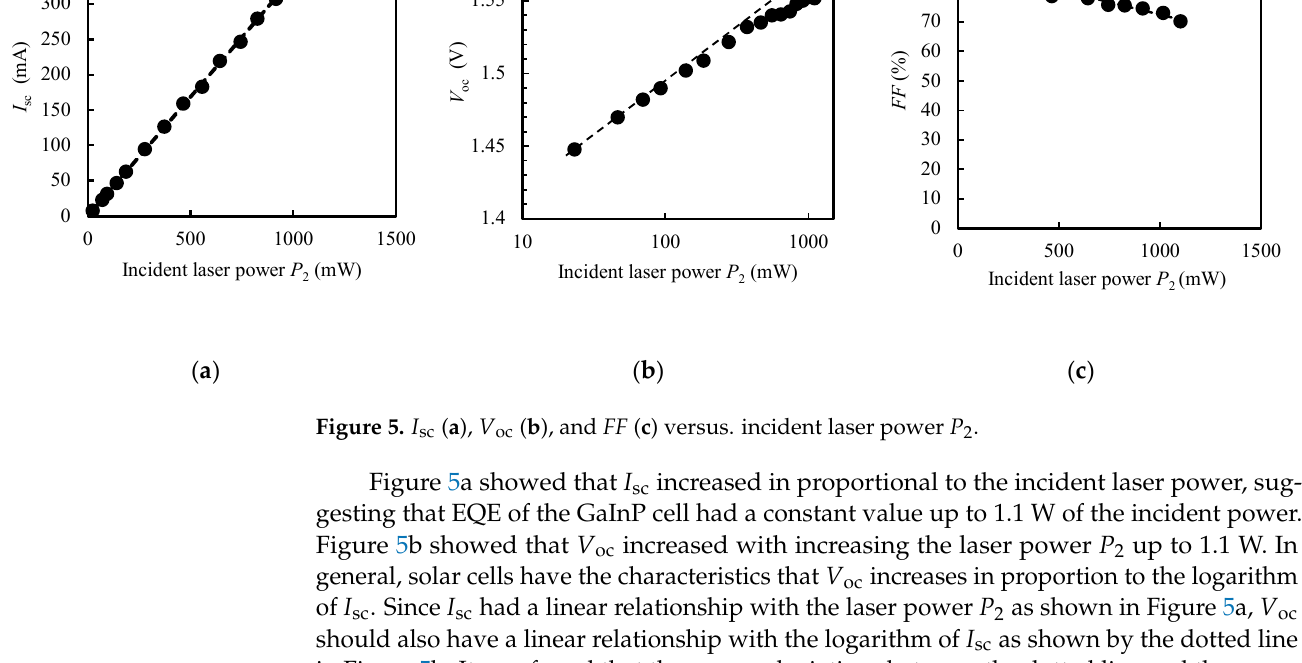
Figure 4. Plots of the optical reaching rate ( a ), photoelectric conversion efficiency ( b ) , and sys- tem efficiency ( c ).